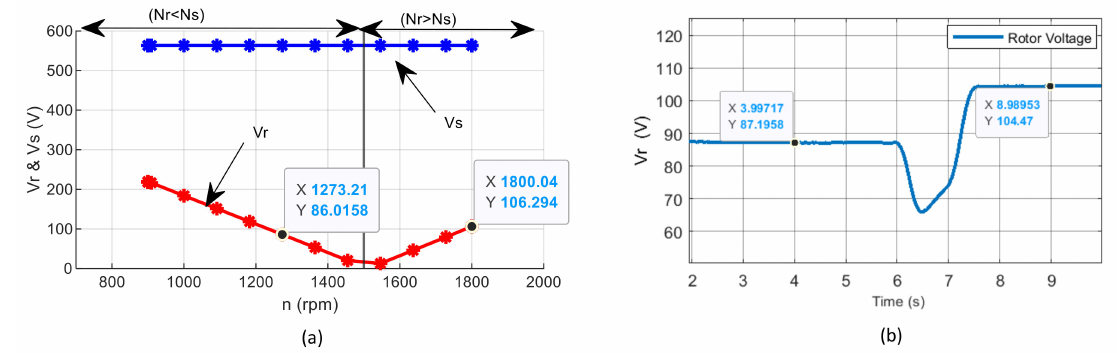
Figure 10. ( a ) Calculated rotor voltage; ( b ) Rotor voltage of the designed system. The stator real power in Figure 11b, varies from 824.698 kW to 1693.45 kW corre- sponding to a speed of 133.33 rad/sec (1273.21 rpm) to 188.5 rad/sec (1800 rpm) and is comparable with the calculated value of − 824.545 kW and − 1693.620 kW as shown in Figure 11a. The stator real power in Figure 12b, varies from 824.698 kW to 1693.45 kW corresponding to a speed of 133.33 rad/sec (1273.21 rpm) to 188.5 rad/sec (1800 rpm). With a transition peak of 261.395 kW. The stator reactive power in Figure 13b, remains constant at 589.357 kVAR. The rotor real power in Figure 11b varies from 130.217 kW to 319.068 kW corresponding to a speed of 133.33 rad/sec (1273.21 rpm) to 188.5 rad/sec(1800 rpm). The rotor reactive power in Figure 13b changes from 14.067 kVAR to − 64.57 kVAR to meet the reactive power demands during subsynchronous and super-synchronous conditions.